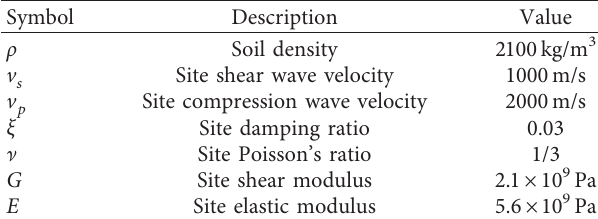
Table 1: List of some important notations and values of